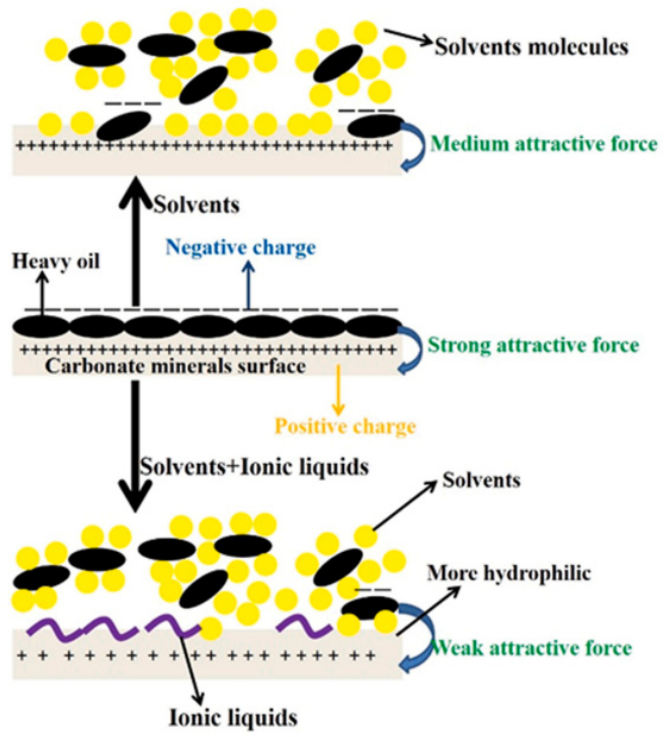
Figure 18. Ionic-liquid-enhanced solvent extraction mechanism. Reprinted with permission from